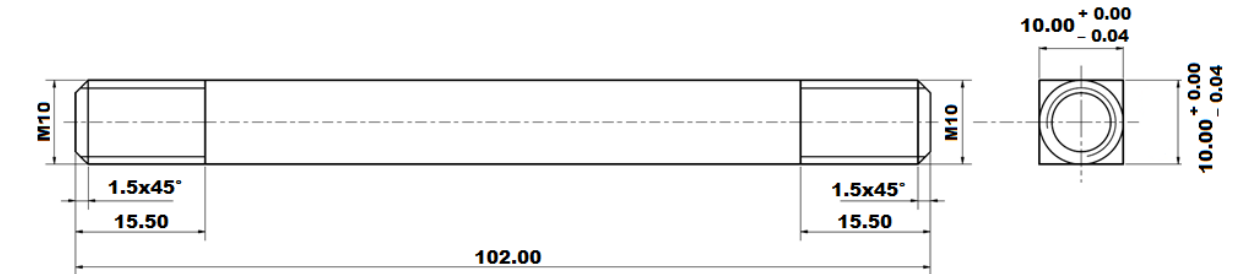
Figure 2. Drawing of the sample used for the physical simulation with subsequent measurements of the residual stresses by XRD.